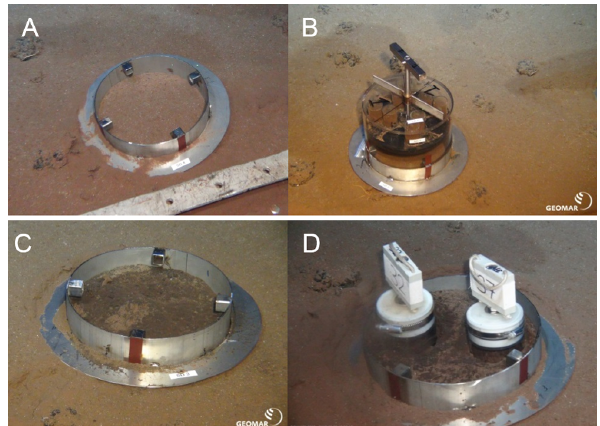
Figure 1. Images of the deployment and sampling during the in situ experiment. (a) Stainless steel ring pressed into the abyssal sedi- ment. (b) Filled nodule particle-distributing device on top of the stainless steel ring before release of the nodule material. (c) Sedi- ment surface after 11d of incubation. (d) Push core sampling at the end of the experiment. Copyright: ROV Kiel 6000 Team/GEOMAR,